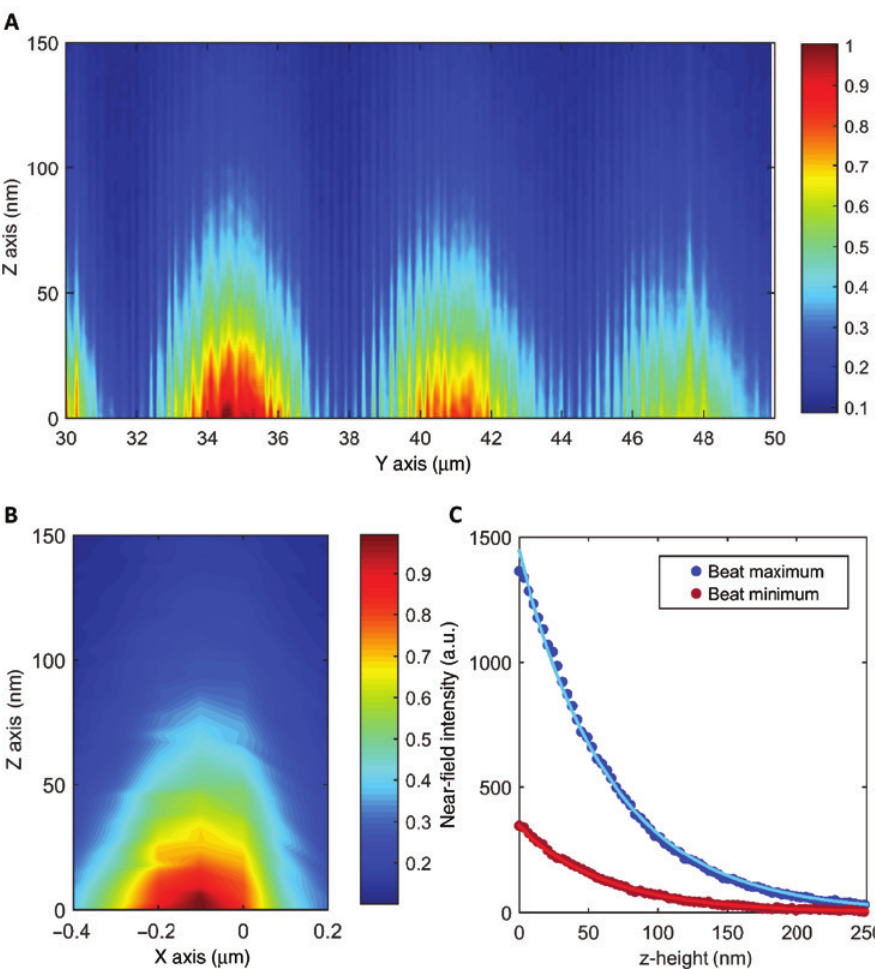
N waveguide. The cross-section 3 4 N 3 4